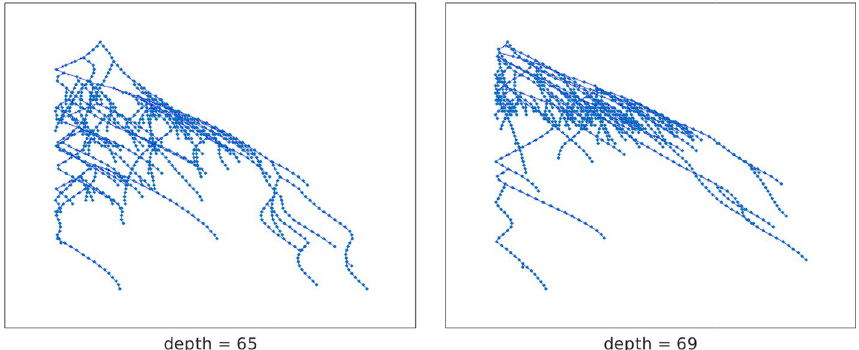
Fig. 19 Network bus-ca (970 vertices): on the left, the out-tree spanning the network rooted at the node corresponding to the “Zuddas” bus stop, the out-center vertex for p = − 10, − 1,0.1 ; on the right, the out-tree rooted at the “San Benedetto” bus stop, out-center node for p =